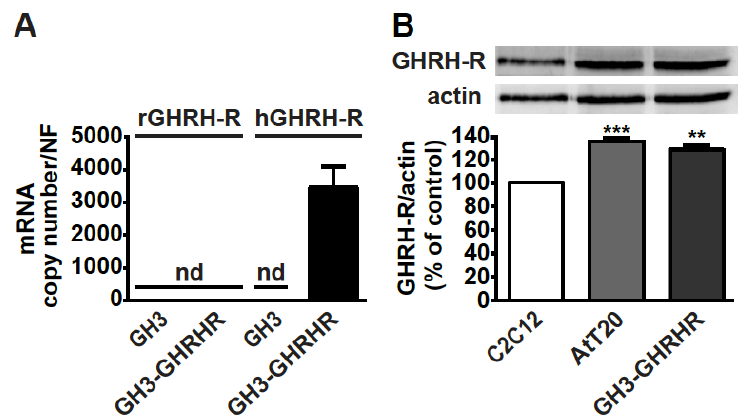
Figure 1. Expression of GHRH-R in GH3-GHRHR and AtT20 cells. ( A ) Real-time PCR for rat (r)GHRH-R and human (h)GHRH-R mRNAs in GH3 and GH3-GHRHR cells. Data represent absolute mRNA copy number adjusted by a normalization factor (NF), calculated from the expression levels of three control genes (GAPDH, ACTB, and HPRT) and are means ± SEM ( n = 3) (nd, not detectable). ( B ) Representative Western blot for GHRH-R protein in AtT20 and GH3-GHRHR cells; C2C12 cells were used as positive control. Equal protein loading was determined by re-probing with antibody to actin. Results, normalized to actin and expressed as percent of C2C12 cells, are means ± SEM. ** p < 0.01, *** p < 0.001 vs. C2C12 cells by unpaired Student ’ s t -test ( n = 3).